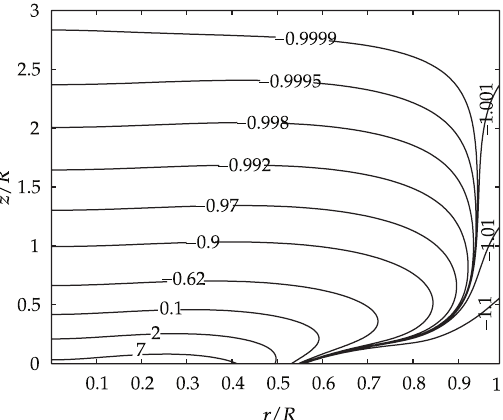
Figure 6: Distribution of the stress σ θ / (cid:6) σ 0 (cid:7) in the lateral condition